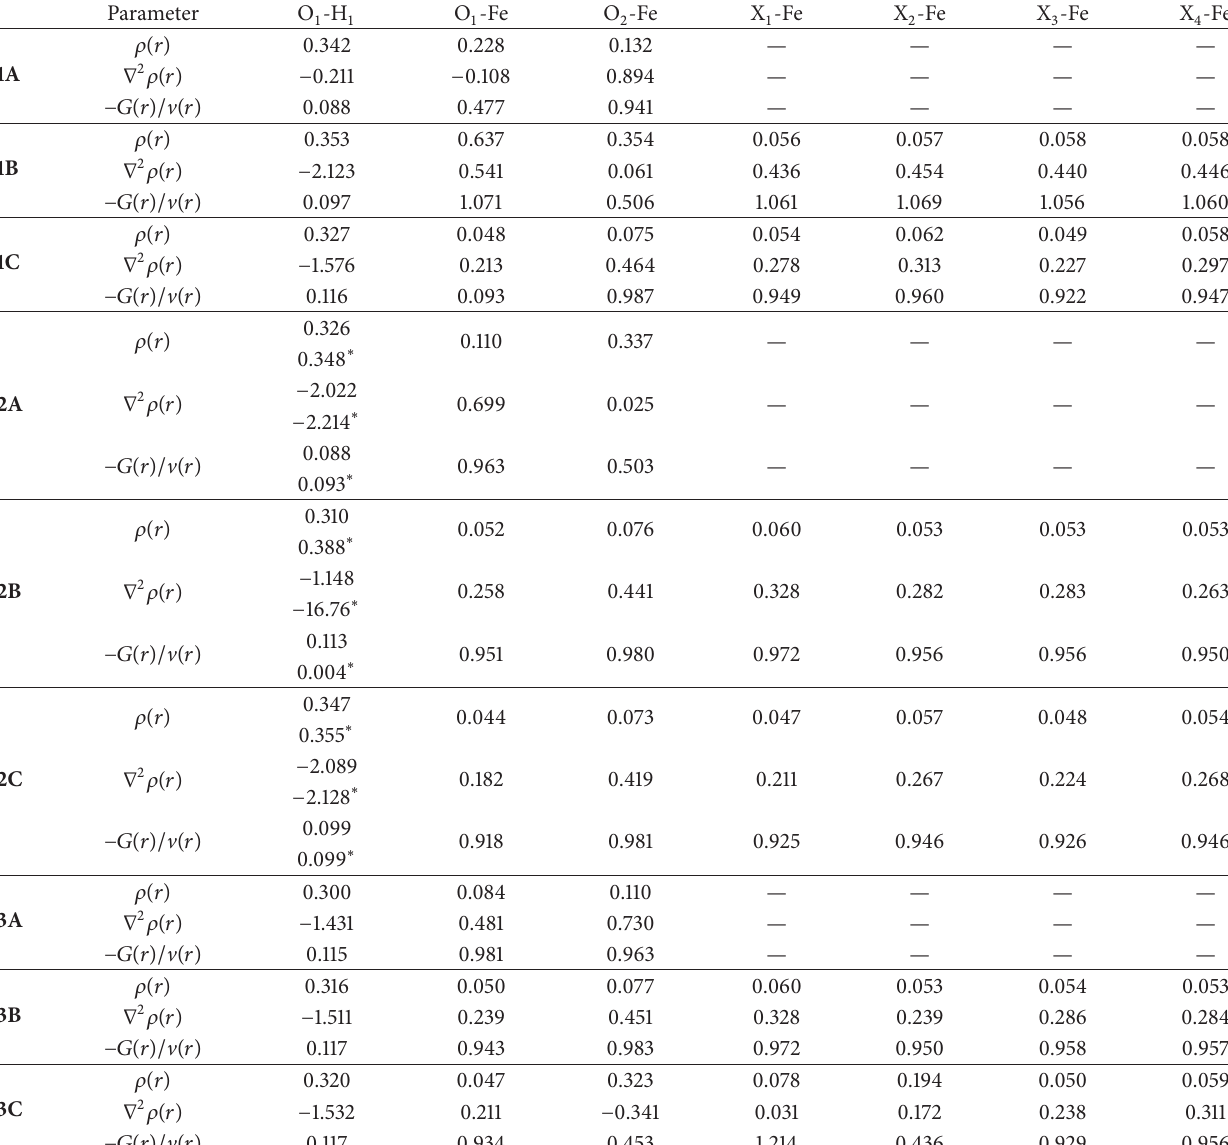
Table 6: Topological analysis of the metal-ligand and O-H bonds of the